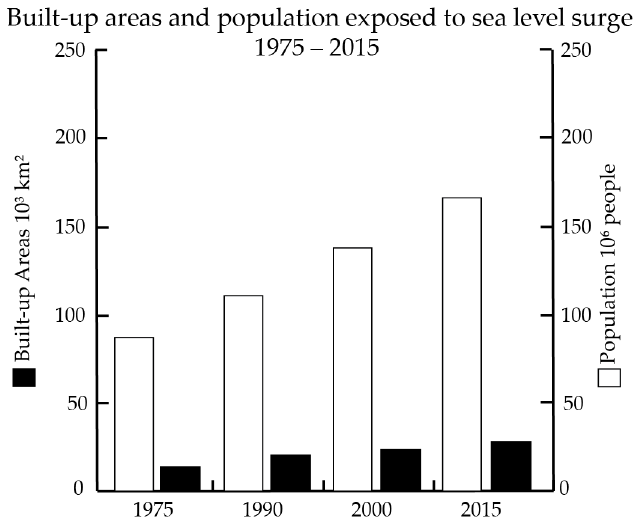
Figure 7. Built-up area and population in areas prone to seal level rise based on a probabilistic hazard assessment from cyclones with return period of 250 years.